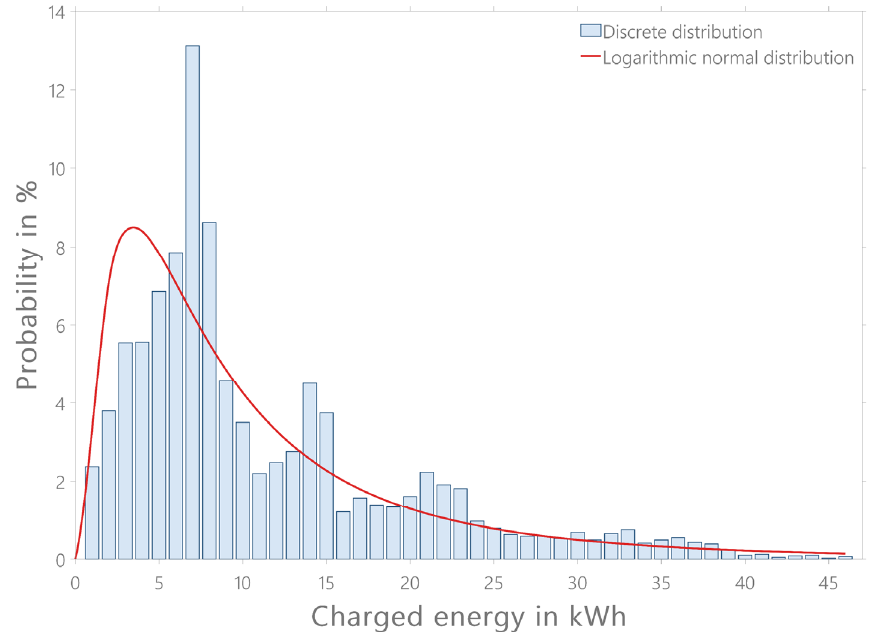
Figure 10. Discrete and logarithmic normal distribution of charged energy probability for a plug-in duration of two hours at a temporal resolution of five minutes.